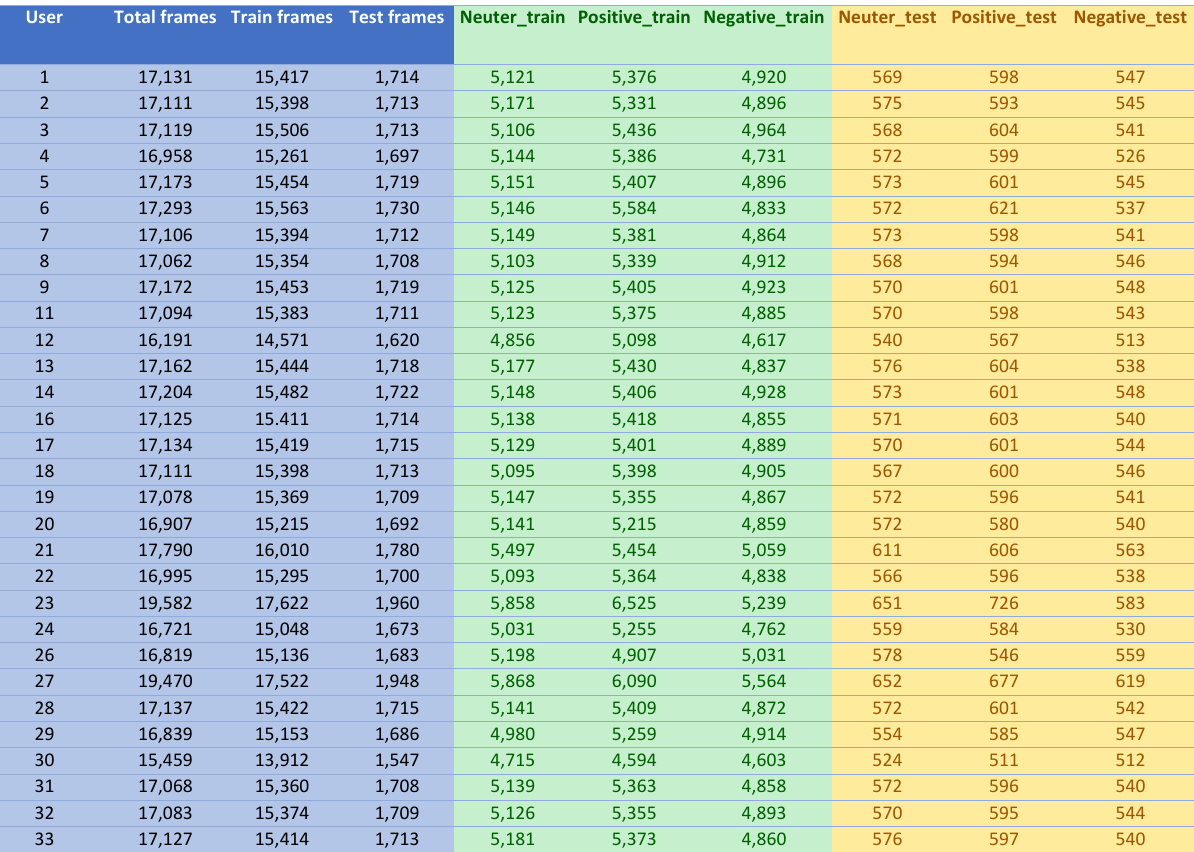
Figure 4. Total frames analyzed for each participant. As reported in Figures 5 and 6, dealing with the raw representation, the KNN obtainedan average precision of 0.85 ± 0.06 and anaverage speed of the algorithm of 6.62 ± 1.62 s. The performance of RF algorithm wasbetter in terms of accuracy (mean ± sd = 0.98 ± 0.01) and execution time (mean ± sd = 5.73 ± 0.86 s) with respect to KNN algorithm. By KNN algorithm, the neutral attitudes showed the worst performance in terms of precision (mean ± sd = 0.82 ± 0.07) and F-measure (mean ± sd = 0.84 ± 0.06) followed bypositive and negative attitudes. According to RF algorithm, all neutral, positive, and negative attitudes had an equal and high precision (mean = 0.98) and F-measure (mean = 0.98). The participant groups that used the robot in static and active modalities did not differ in all considered variables according to KNN and RF